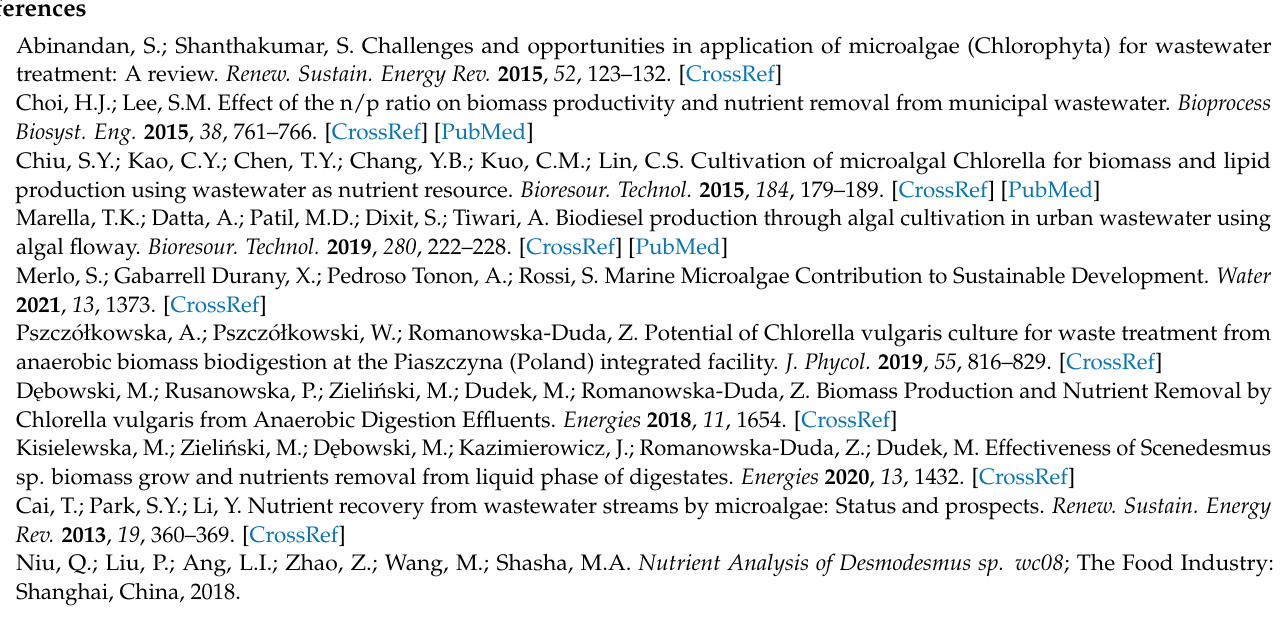
chart; Figure S2: Statistical map of KEGG metabolic pathway classification; Table S1: All metabolites detected by metabolome in positive polarity mode. Table S2: All metabolites detected by metabolome in negative polarity mode. Table S3: The differentially expressed genes and differentially accumu- lated metabolites are simultaneously mapped to the KEGG pathway diagram in positive polarity mode. Table S4: The differentially expressed genes and differentially accumulated metabolites are simultaneously mapped to the KEGG pathway diagram in negative polarity mode. Table S5: The differentially expressed genes and differentially accumulated metabolites are simultaneously mapped to the KEGG